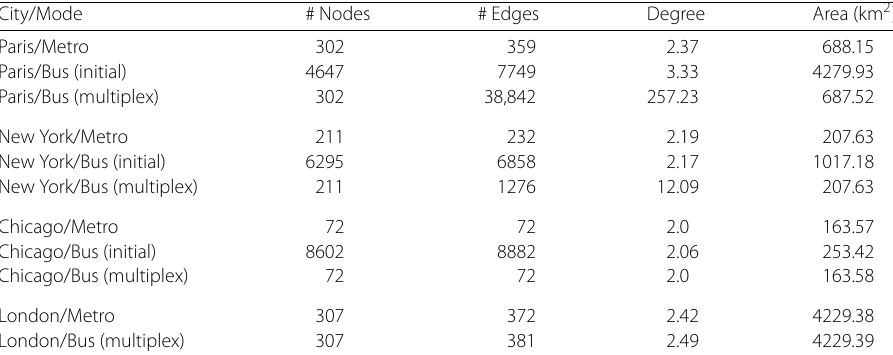
Table 1 Basic statistics about different transportation networks used in this study. Bus (initial) is the initial bus network extracted from GTFS files; Bus (multiplex) is the part of the initial bus network that matches the metro network in the city. Edges in Bus (multiplex) are routes (paths) extracted from Bus (initial)